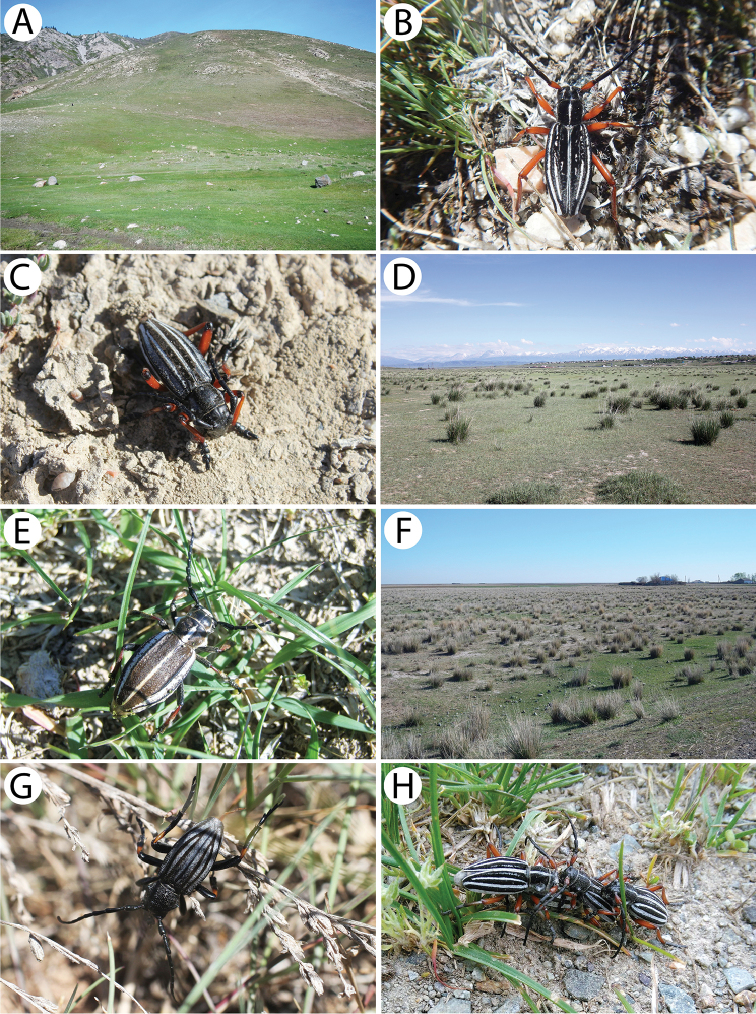
Field photos of imagines in nature and habitats of typical Kazakh cerambycid species: A steppe area in Arkhaly environs, the habitat of DorcadionabsinthiumishkoviB male of DorcadionacutispinumC male of DorcadionarietinumarietinumD mountain steppe area in Kegen environs, the habitat of D.arietinumarietinum, Dorcadioncrassipescrassipes and DorcadionsemenovisemenoviE female of DorcadiongeblerigebleriF mountain steppe area in Zaysan environs, the habitat of D.geblerigebleriG male of D.semenovisemenoviH particular behavior of a few individuals of Dorcadionsokolowi.